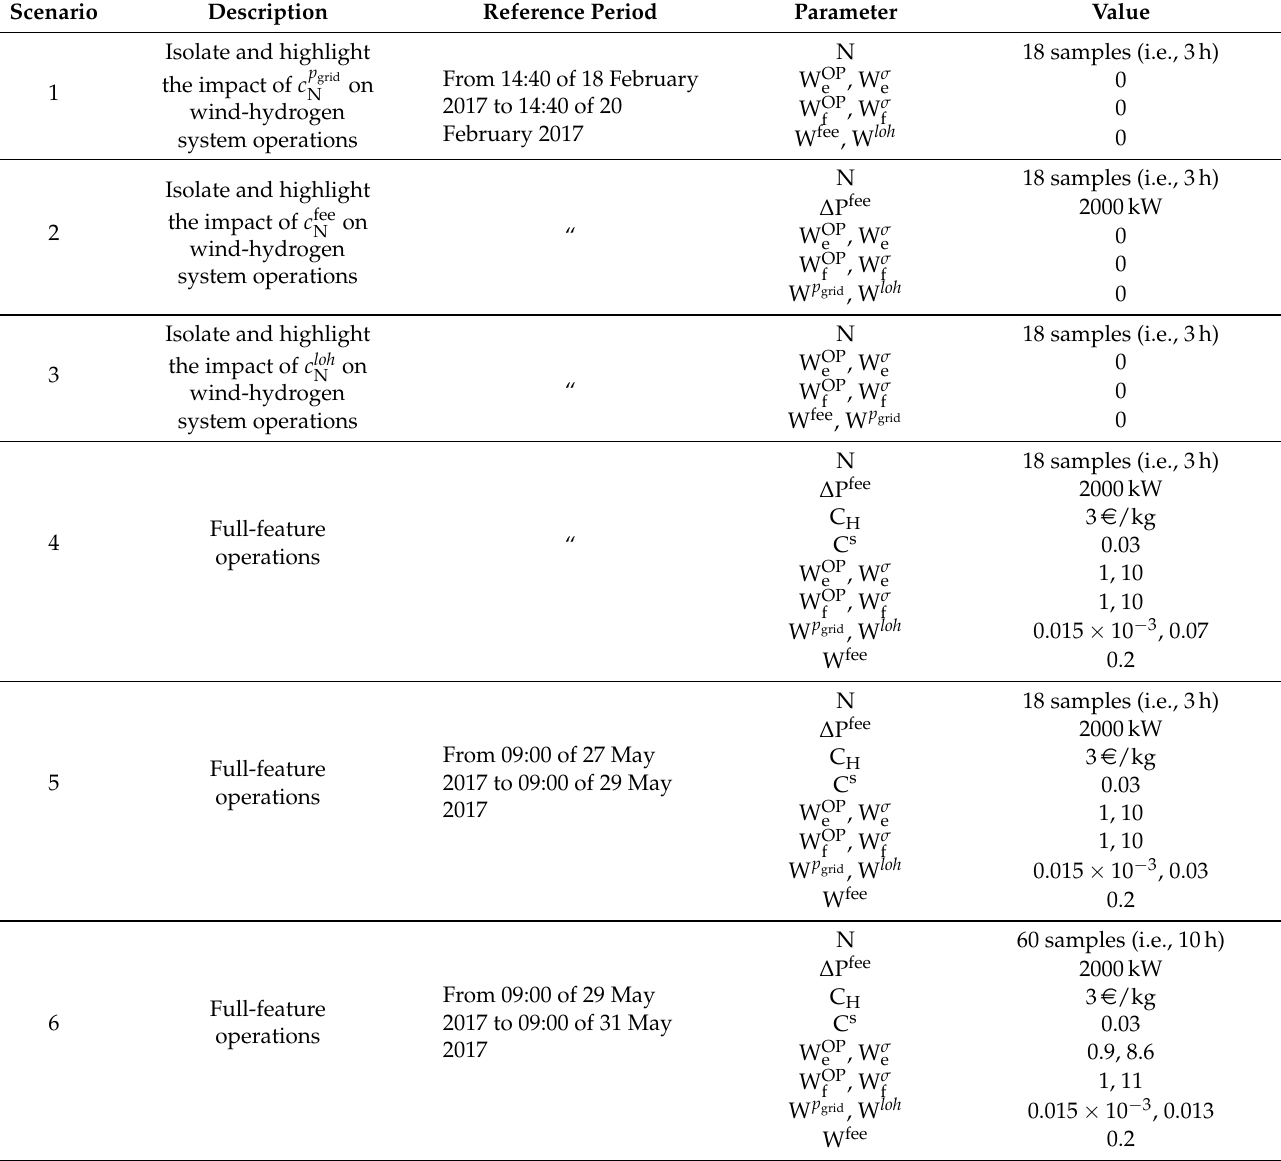
Table 3. Summary of the addressed